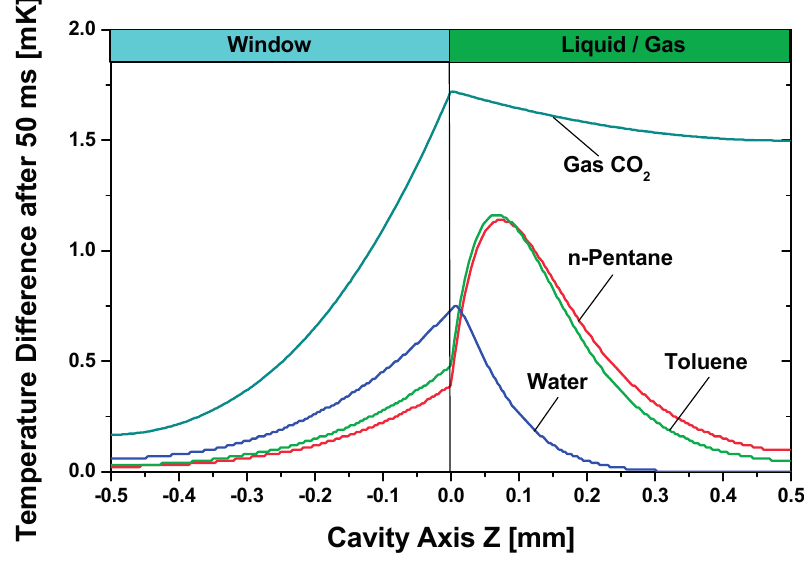
Figure 18. Temperature distribution along the cavity axis 0.5 s after the onset of irradiation for different liquids with an IR power density at the outer window surface of 10 W/m 2 . For gas an absorption zone at the inner window surface is